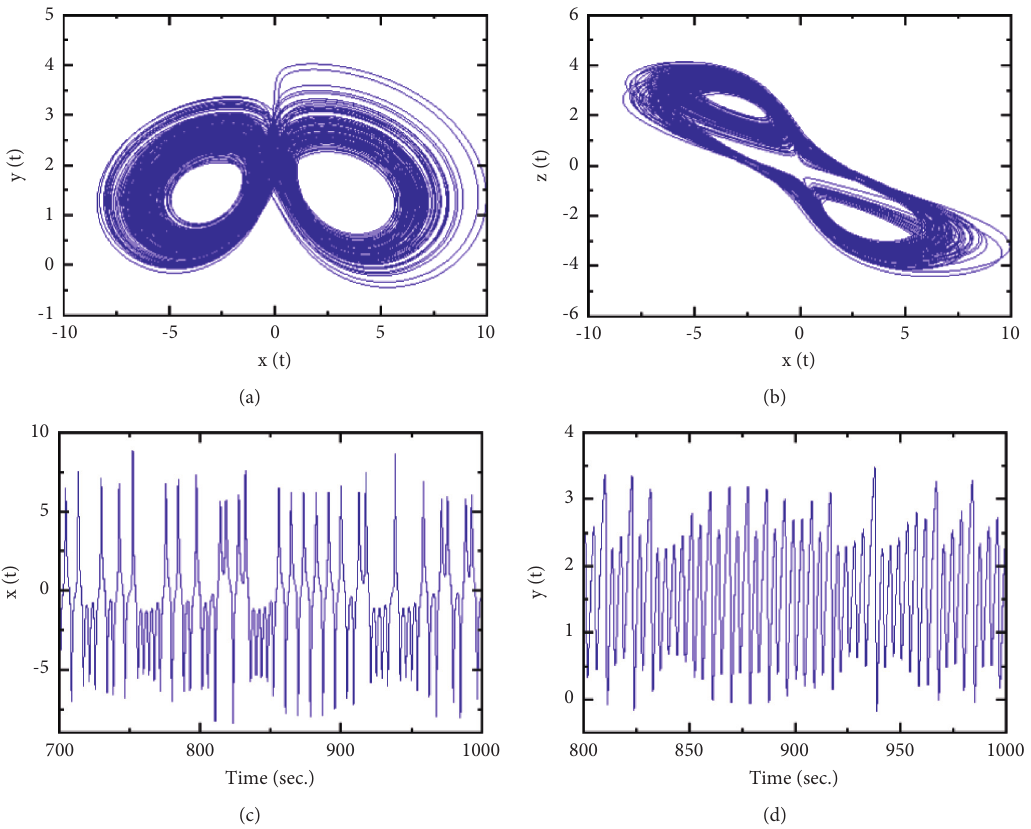
Figure 3: Phase diagrams and time series of system (6) with fractional order q � 0 . 83: (a) projected onto the x − y phase plane, (b) projected onto the x − z phase plane, (c) time series of x, and (d) times series of y .